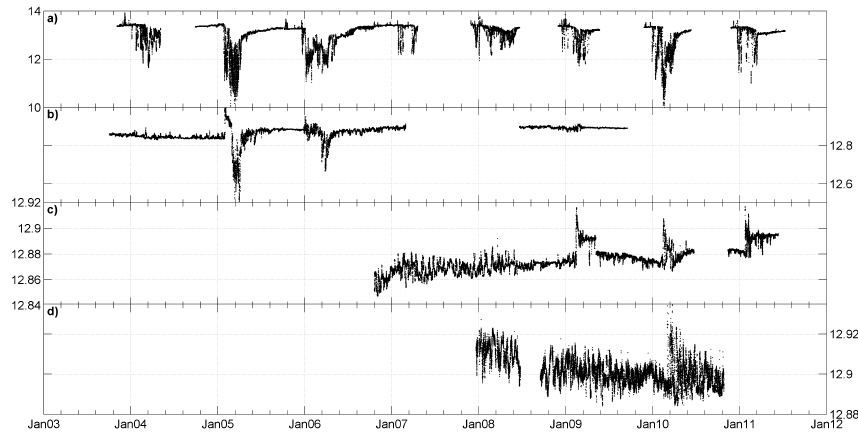
Fig. 6. θ times series in (a) CCC (at 315m), (b) CS (at 1875m), (c) GoL (at 2400m) and (d) ANTARES (at 2200m). Note that scales are